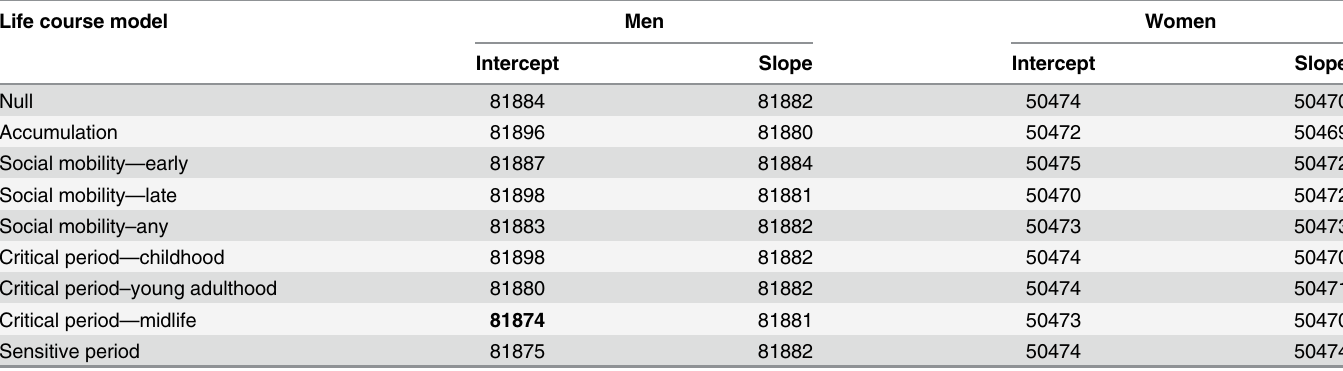
Table 7. Relative model fit of life course model